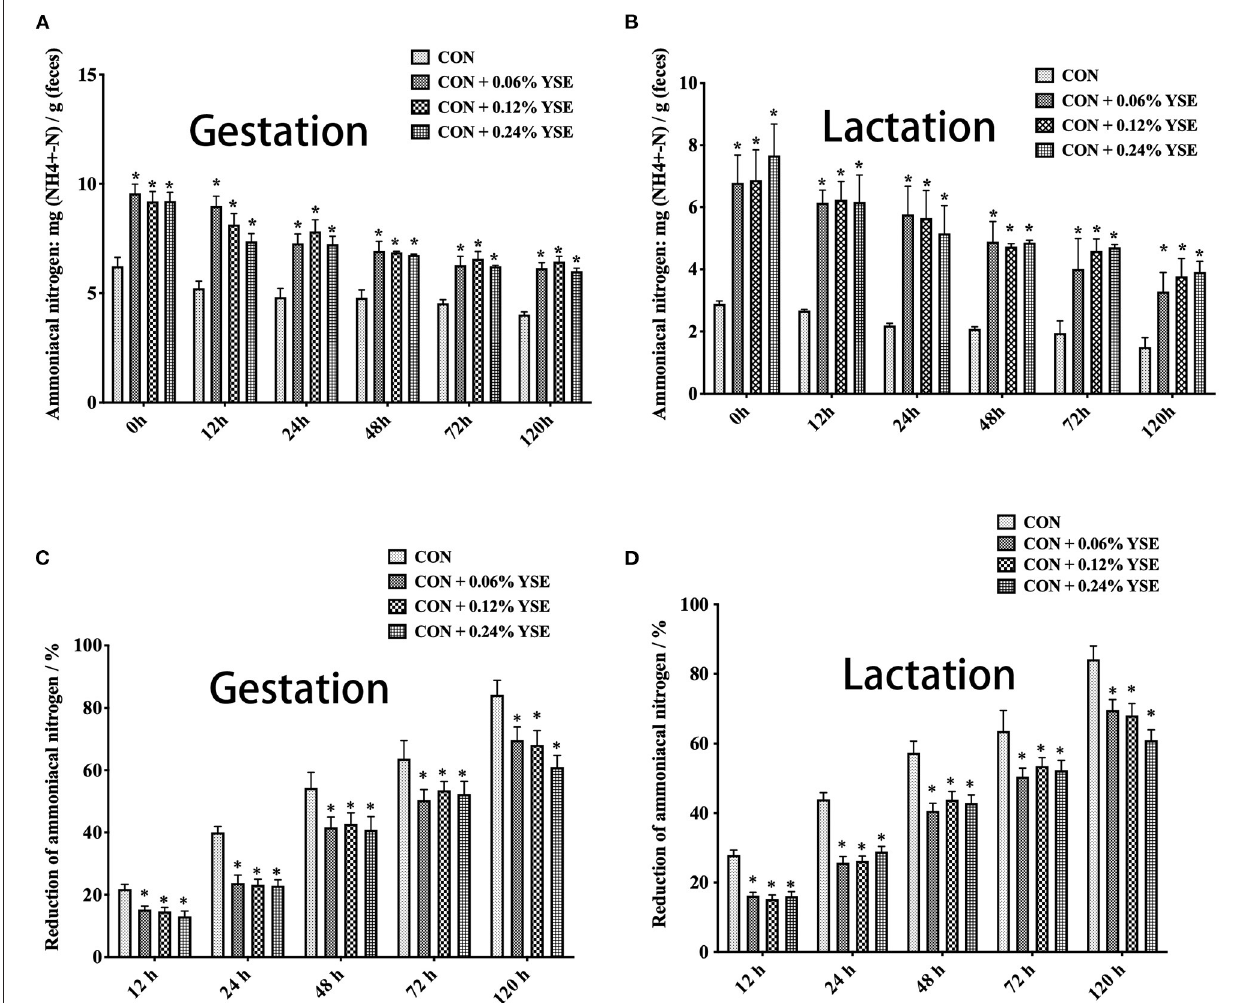
FIGURE 3 | The effect of dietary YSE supplementation on ammoniacal nitrogen content and loss of ammoniacal nitrogen in manure of gestating and lactating sows during storage. (A) The effect of dietary YSE supplementation on ammoniacal nitrogen content in manure of gestating sows during storage; (B) The effect of dietary YSE supplementation on ammoniacal nitrogen content in manure of lactating sows during storage; (C) The effect of dietary YSE supplementation on loss of ammoniacal nitrogen in manure of gestating sows during storage; (D) The effect of dietary YSE supplementation on loss of ammoniacal nitrogen in manure of lactating sows during storage. * means significant